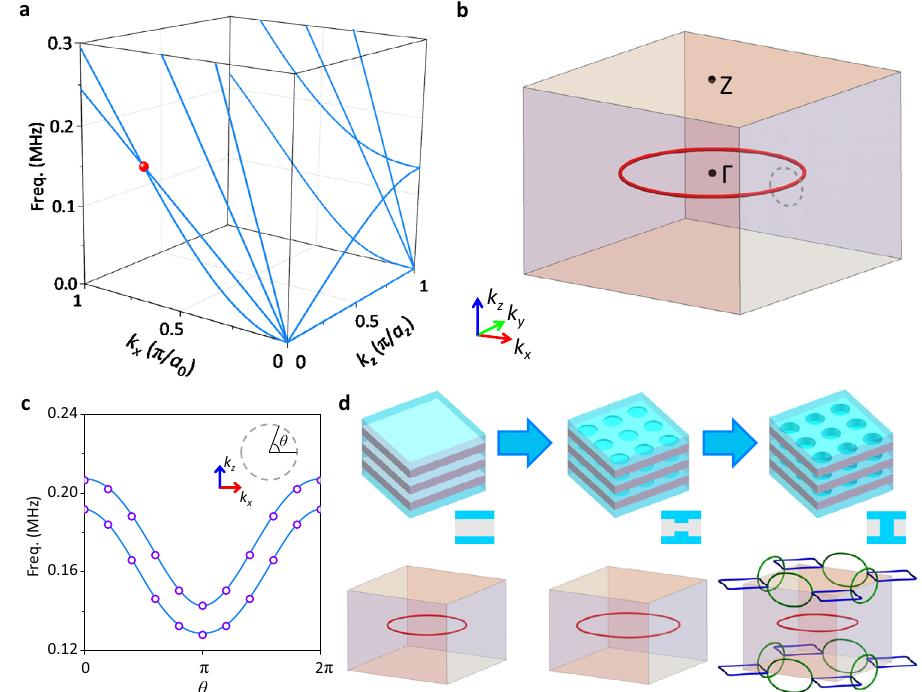
Fig. 2 | Origins and analysis of the nodal rings. a Band structure of periodic metallicplateswithoutperforations. b Distributionoftheidealtype-IInodalringfor ( a ).Noothernodalringsexist. c Band structureonthe dashed loopdenoted in( b ). The radius of the circular loop is 0.1 π / a 0 . Solid lines and hollow dots respectively Brillouinzone(FBZ)featurestheiremergencefromzerofrequencyat Γ